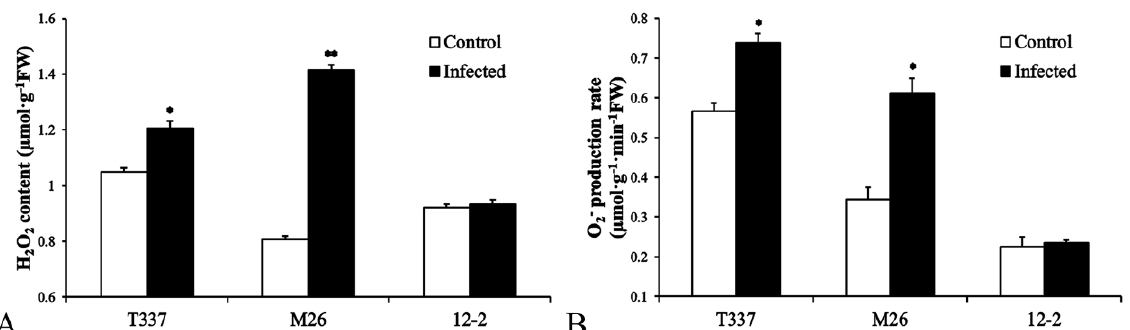
Figure 5. Effects of F. proliferatum MR5 on leaf reactive-oxygen-species levels: ( A ) H 2 O 2 content; ( B ) O 2 − production rate. The Student’s t -test was used to detect differences between the control and infected treatments within a rootstock. * p < 0.05; ** p <